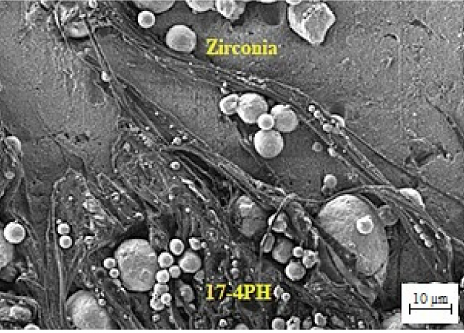
Figure 5. FESEM image of the solvent-debound 17-4PH/zirconia micro-specimen.